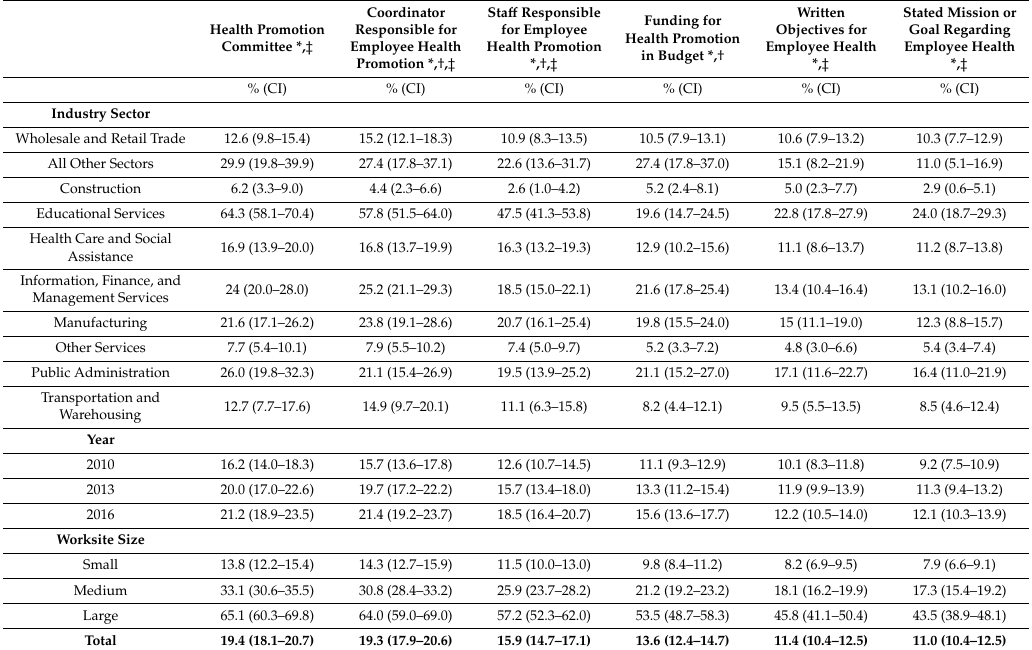
Table 2. Weighted percentage of worksite responses to implementing workplace health strategies by industry sectors, survey years and worksite